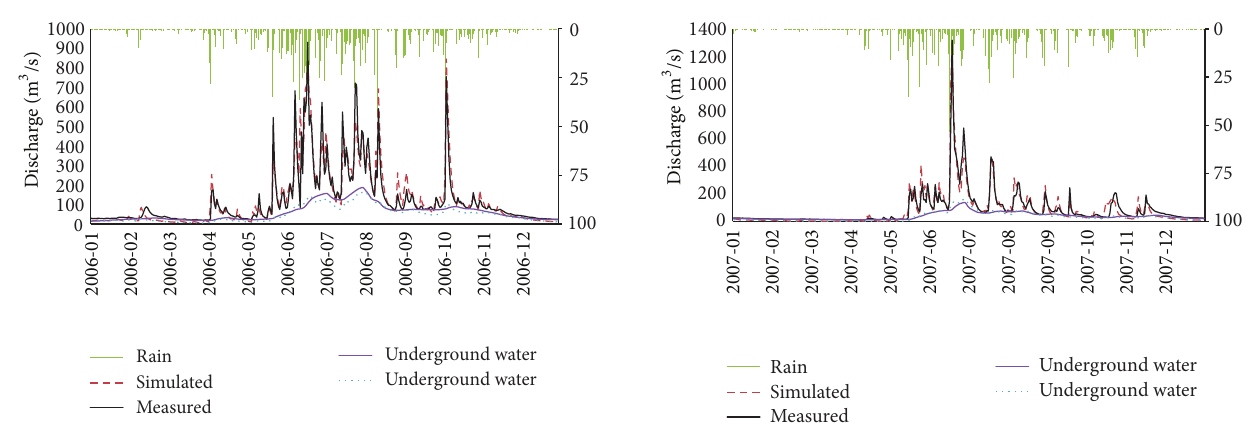
Figure 6: XAJ model validation phase (2007). Measured and simu- lated discharge, the groundwater runoff separated from the hydro- graph and calculated by Xin’anjiang model, and catchment average rainfall time series.